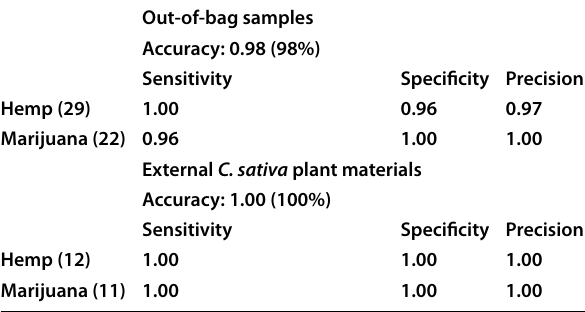
Table 2 Performance results of the random forest model for prediction of “out-of-bag” and external validation samples